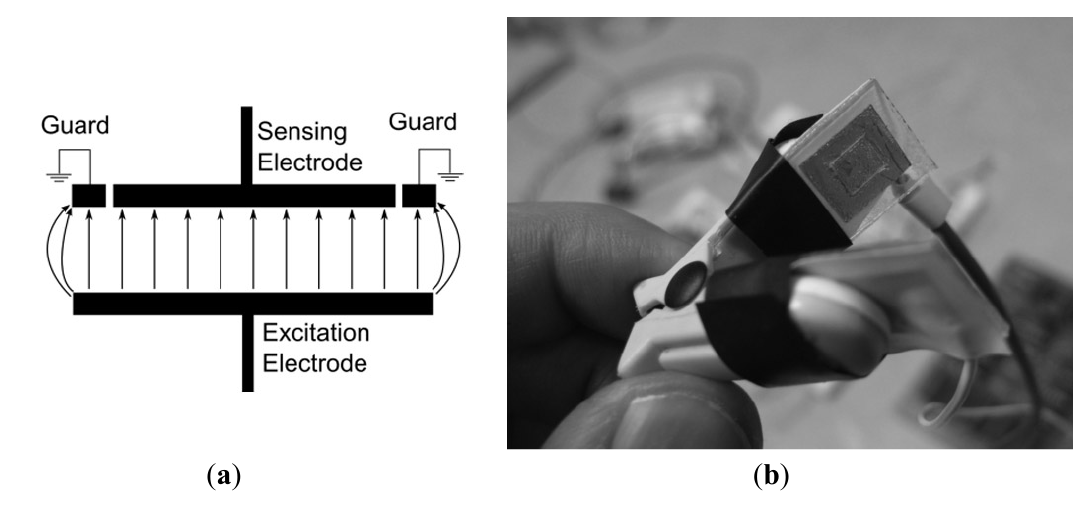
Figure 1. ( a ) Diagram of guarded capacitance sensor. ( b ) Photograph of sensor